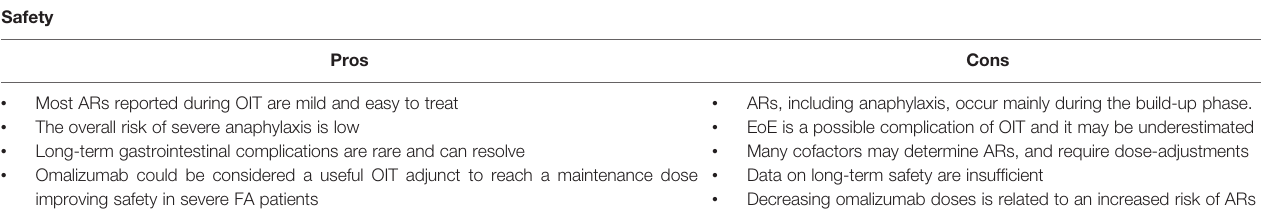
TABLE 2 | Safety of OIT in children – pros and